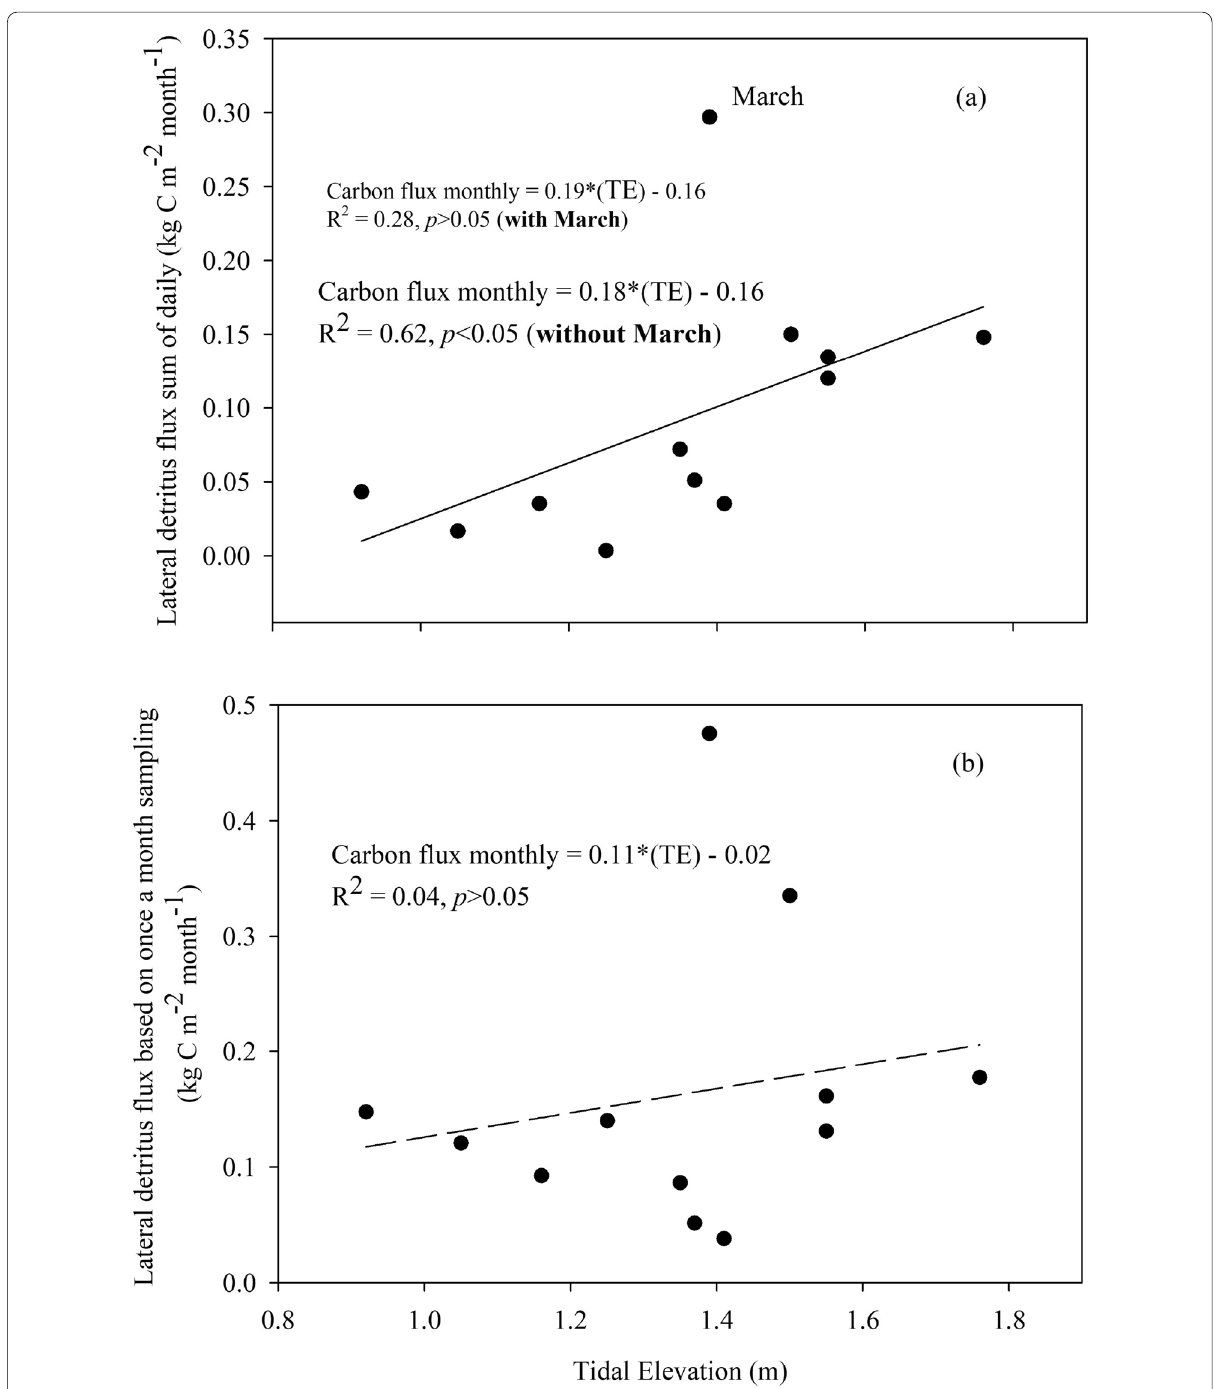
Fig. 5 Linear relationships between tidal elevation and lateral detritus fluxes based on the daily sum ( a) and monthly total (